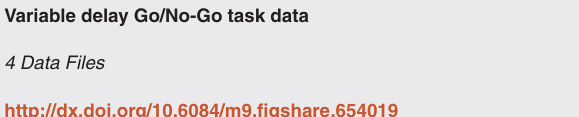
figshare: Variable delay Go/No-Go task data, http://dx.doi.org/10.6084/ m9.figshare.654019 10